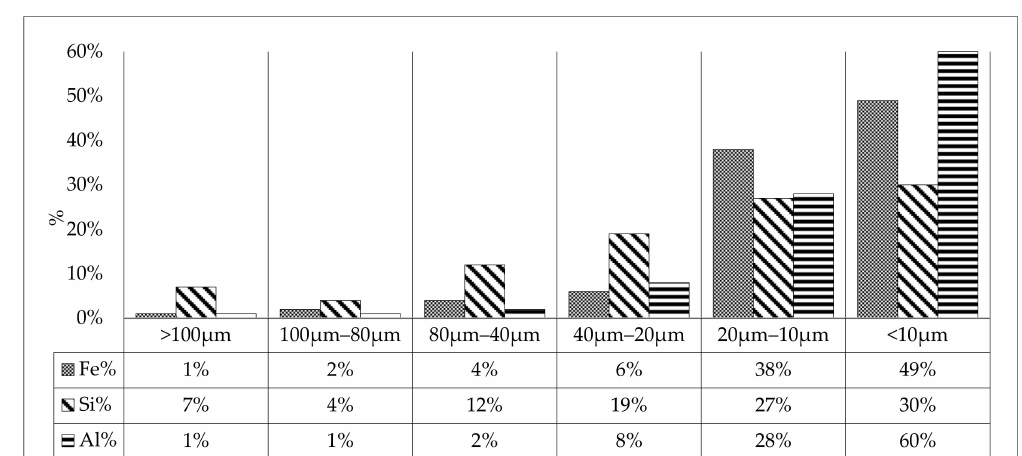
Figure 4. Fe, Si and Al in feed according to size fractions.